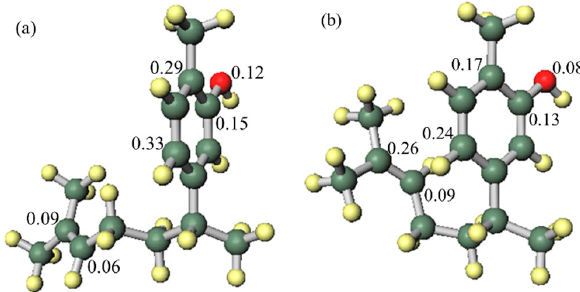
Figure 4. Spin density of the xanthorrhizol ( 1 ) radical cation: ( a ) far side chain conformation, ( b ) close side chain conformation.